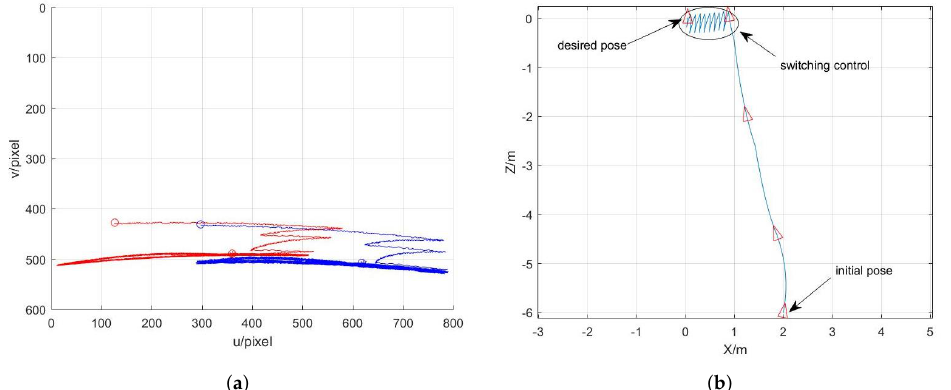
Figure 6. Simulation of the initial poseture X 0 = [ 2, − 6,10 ◦ ] T . ( a ) Feature trajectories. ( b ) Motion trajectory.